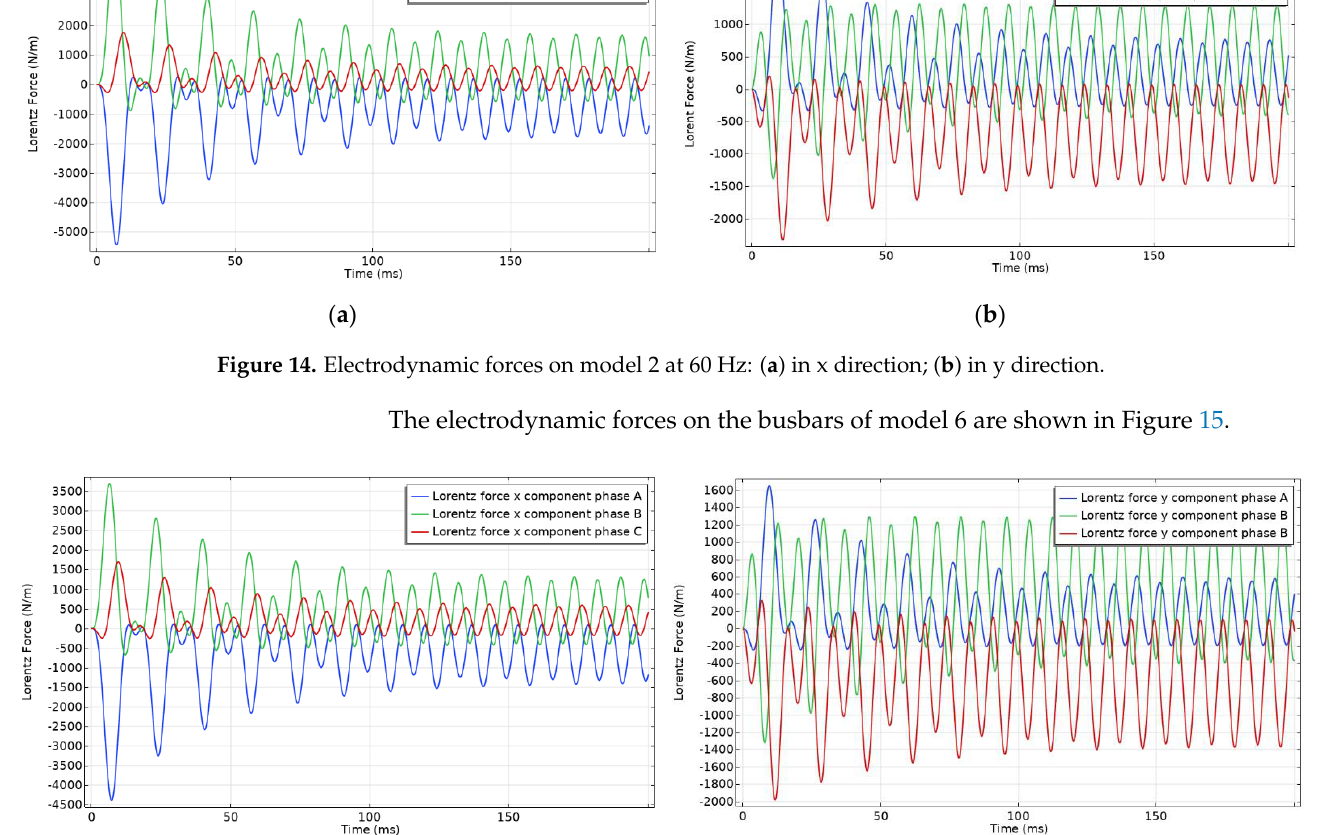
Figure 14. Electrodynamic forces on model 2 at 60 Hz: ( a ) in x direction; ( b ) in y direction. The electrodynamic forces on the busbars of model 6 are shown in Figure 15.